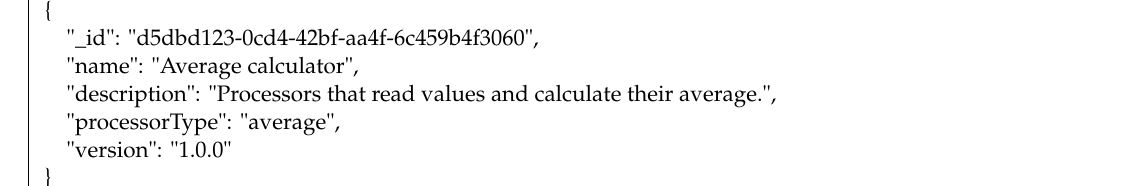
Table 5. Modelling of APD for Calculating an